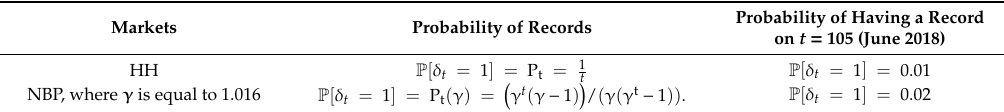
Table 6. Probability of records